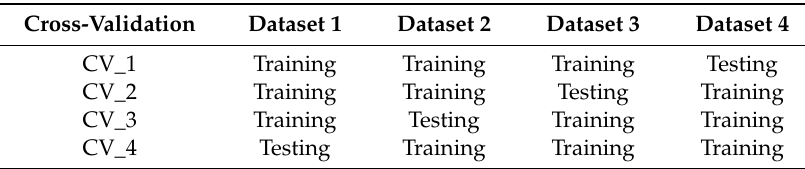
Table 4. Cross-training and dataset